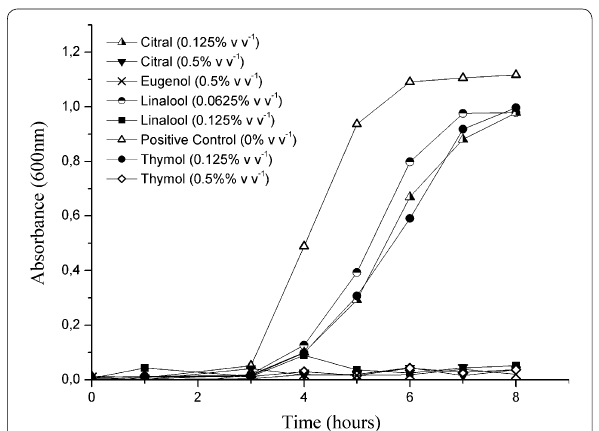
Fig. 1 Planktonic cell growth curve of S. flexneri in medium with EO major